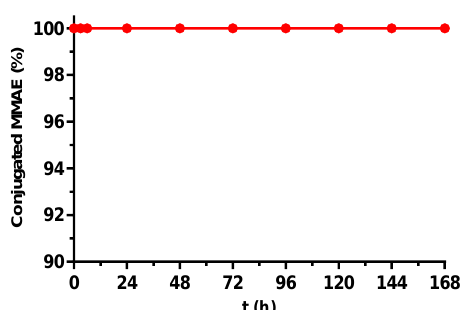
Figure 3. Stability of the Cys-linker-MMAE-based ADC in 50% plasma at 37 °C. The test concentration of mil40- 15 was 250 nM, and the lower limit of quantification (LLOQ) and upper limit of quantification (ULOQ) of MMAE were 2 nM and 250 nM, respectively. Each sample point contains two repetitions and the results are shown as the mean.